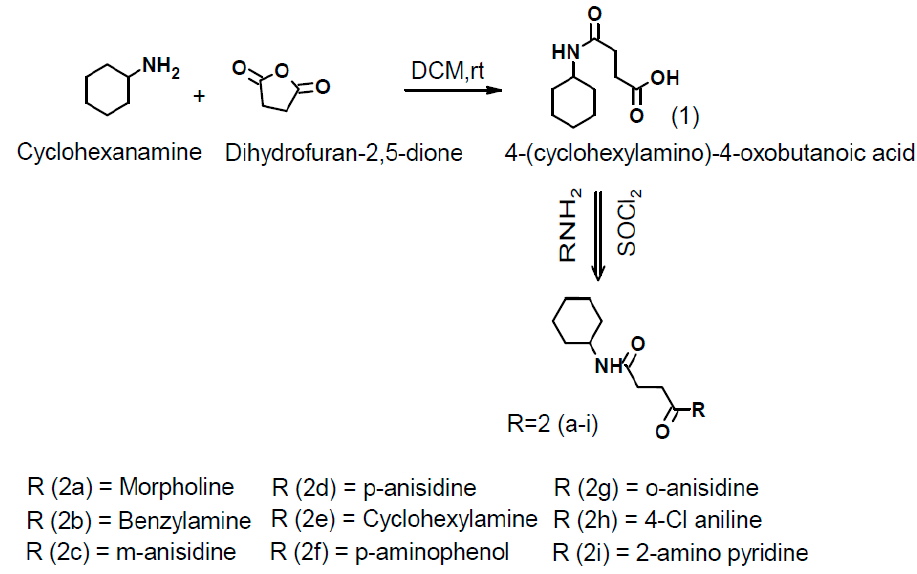
Figure 1. Scheme for the synthesis of new succinamide derivatives. DCM, dichloromethane; rt, room temperature; SOCl 2 , thionyl chloride.